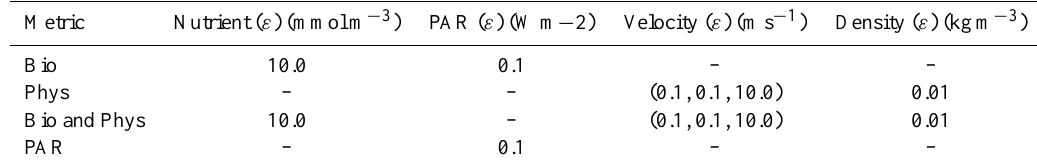
Table 1. Weighting of fields used for each metric used in this study. A “–” indicates that this field was not used in the metric construction. See Eq. (15).